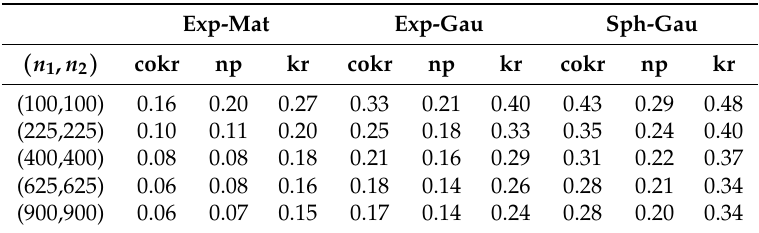
Table 3. AMSPE values obtained for several sample sizes n 1 and n 2 , for data drawn from random fields Z 1 and Z 2 with constant trends, derived from Gaussian processes V 1 and V 2 with exponential and Matérn semivariograms, respectively. For implementation of the kriging and cokriging approaches, the dependence structures of V 1 and V 2 were estimated through the theoretical models (Exp-Mat), together with misspecified alternatives either for the second process (Exp-Gau) or for both processes (Sph-Gau). Exp-Mat Exp-Gau Sph-Gau cokr np